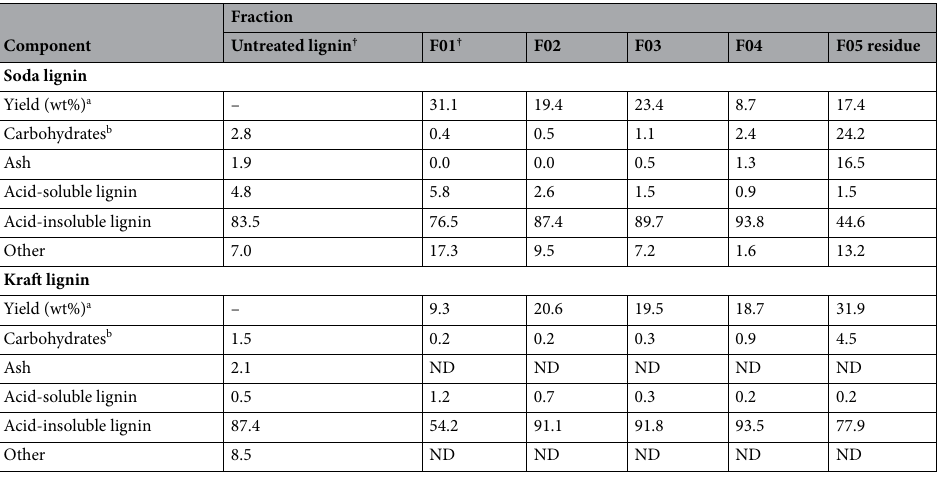
Table 1. Yield and composition data (weight %) for P1000 soda lignin and Indulin AT Kraft lignins and their solvent fractions used in the present study. Details of fractions are provided in Methods: F01, ethyl acetate fraction; F02, methyl ethyl ketone fraction; F03, methanol fraction; F4, acetone:water (4:1) fraction; and F05, residue. ‘Other’ materials are 100% minus the sum of the identified and quantitated components, and typically can be assumed to be proteins (P1000 Soda lignin) or possibly wood extractives (Indulin AT). ND, not determined. a wt%, dry wt basis of initial starting lignin. b Calculated as polysaccharide. Error analyses < 5% relative. † Data for untreated soda lignin and its ethyl acetate fraction (F01) have been previously published 62